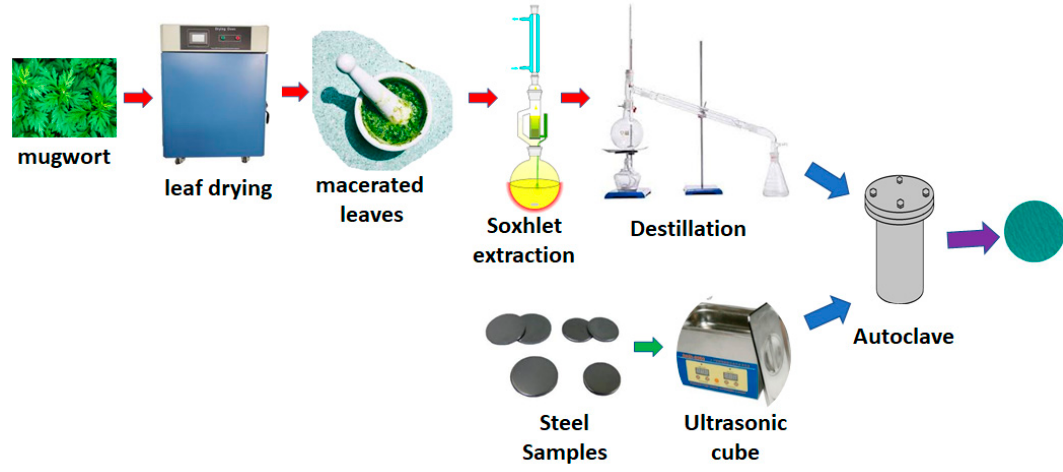
Figure 1. Experimental setup.